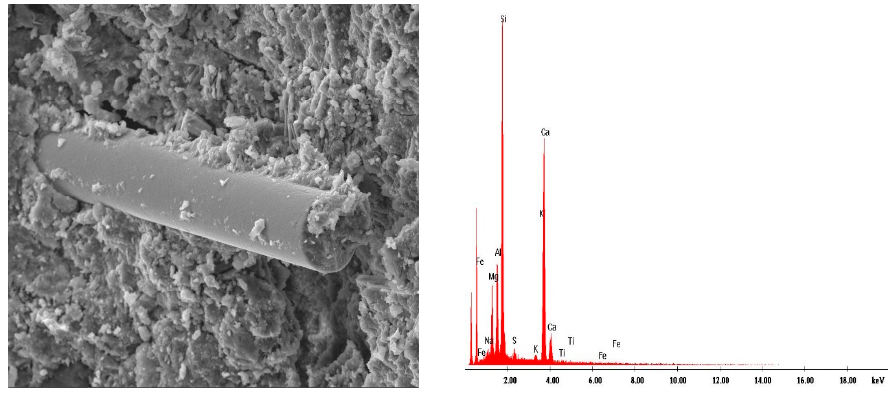
Figure 10. Single POF bundle structure in a cement matrix and elemental analysis results in the EDS micromatrix of a cement matrix at 100X